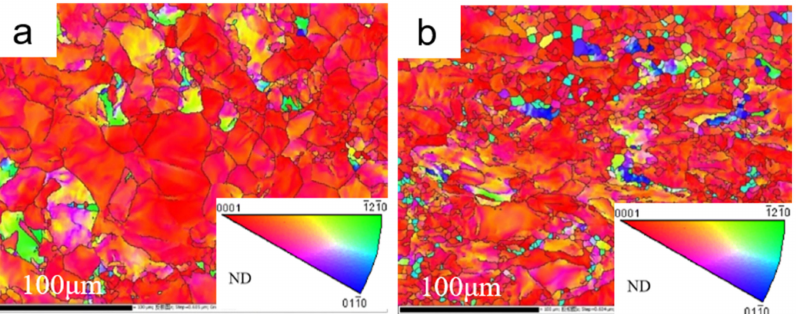
Figure 5. Grain orientation map of TA2 alloy with different degrees of cold-rolling deformation.